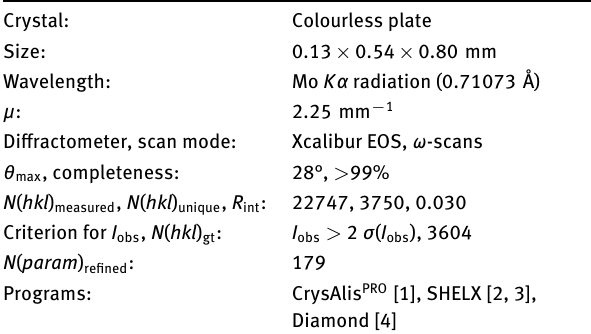
Table 1: Data collection and